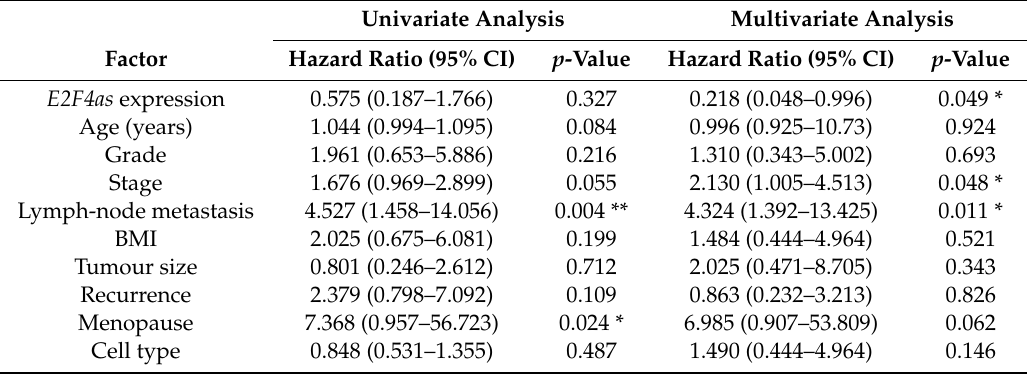
Figure 2. Overall survival of E2F4as expression in ovarian cancer patient serum. ( A ) Receiver operating characteristic (ROC) curve for prognosis prediction of patients using E2F4as level. Area under the curve (AUC) shown in plots. ( B ) Relative E2F4as expression and its clinical significance based on Kaplan–Meier overall survival curves of patients with ovarian cancer and different levels of E2F4as . Table 2. Univariate and multivariate analyses of parameters associated with overall survival in 108 patients with ovarian cancer.